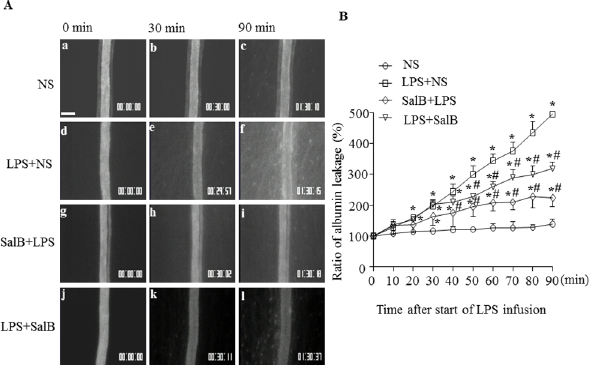
Fig 1. The influence of SalB on albumin leakage from rat mesenteric venules. A : Representative images of fluorescence microscopy showing rat mesenteric venules at baseline (0 min), and 30 and 90 min after reagent infusion in different groups. Bar = 50 μ m. B : Time course of albumin leakage form venules in different groups. Data were expressed as mean ± SE of 6 animals. * p < 0.05 vs. NS group; # p < 0.05 vs. LPS group. For albumin leakage analysis, repeated measures ANOVA with Bonferroni post hoc test were used.